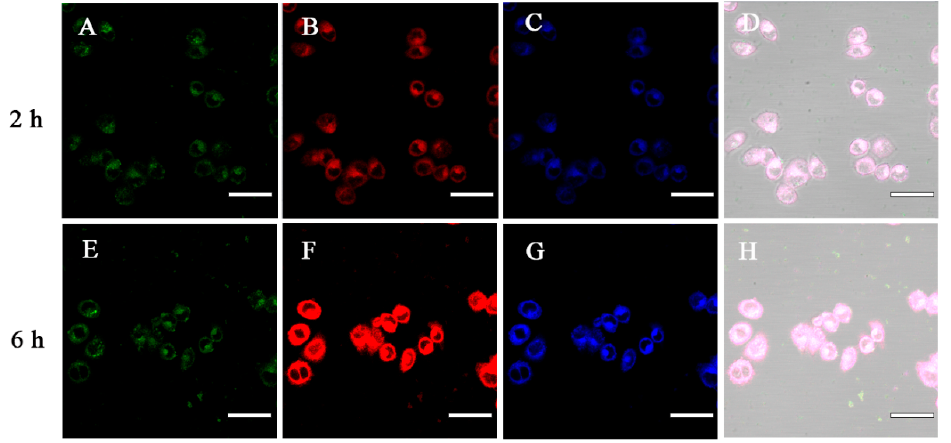
Figure 8. Confocal microscopy images of HeLa cells incubated with RS@MS(Dox):dsPEI-siRNA na- noparticles for 2 h ( A – D ) and 6 h ( E – H ) at 37 °C, respectively. The RS@MS was recorded in the green